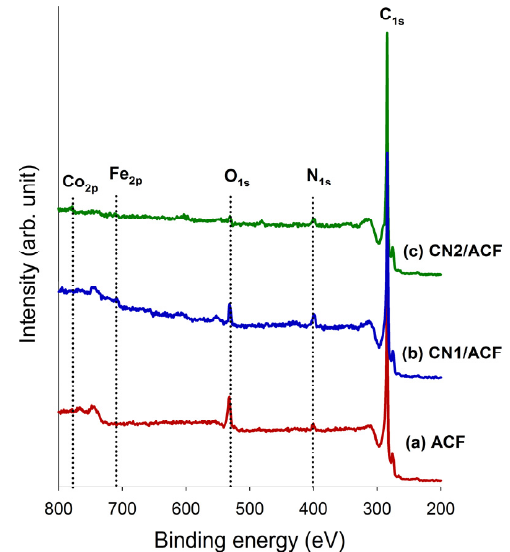
Figure 3. The X-ray photoelectron spectroscopy (XPS) survey scan spectra of the samples: ( a ) as-received